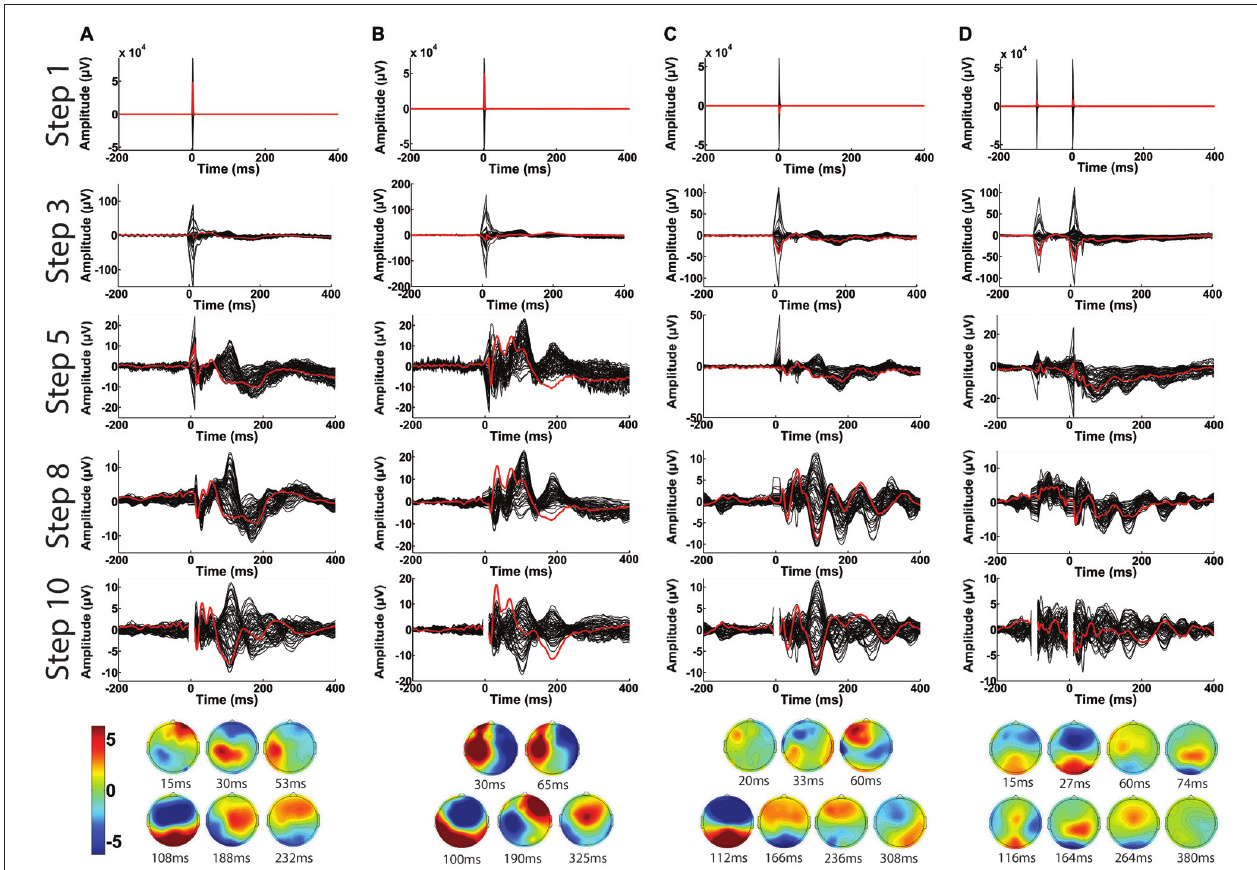
FIGURE 14 | Illustration of the capability of TMSEEG in processing several types of single-pulse and paired-pulse TMS paradigms. Panels illustrate the average butterfly plot of the TEPs at the completion of each major processing step (1, 3, 5, 8 and 10). The channel closest to the stimulation site is highlighted in red in each plot (C3 for left motor cortex and F3 for DLPFC). X -axes represent time in milliseconds relative to presentation of TMS pulse and y -axes represent the amplitude of the EEG signal in µ V. The topographical plots at the bottom illustrate the voltage scalp map at each significant peak of the butterfly plot from Step 10 in µ V. The displayed TMS-EEG paradigms are: (A) single-pulse stimulation applied to the left motor cortex at rest, (B) single-pulse stimulation applied to the left motor cortex during active muscle contraction (cortical silent period paradigm), (C) single-pulse stimulation applied to the left DLPFC at rest, and (D) paired-pulse (long-interval cortical inhibition paradigm) applied to the left DLPFC at